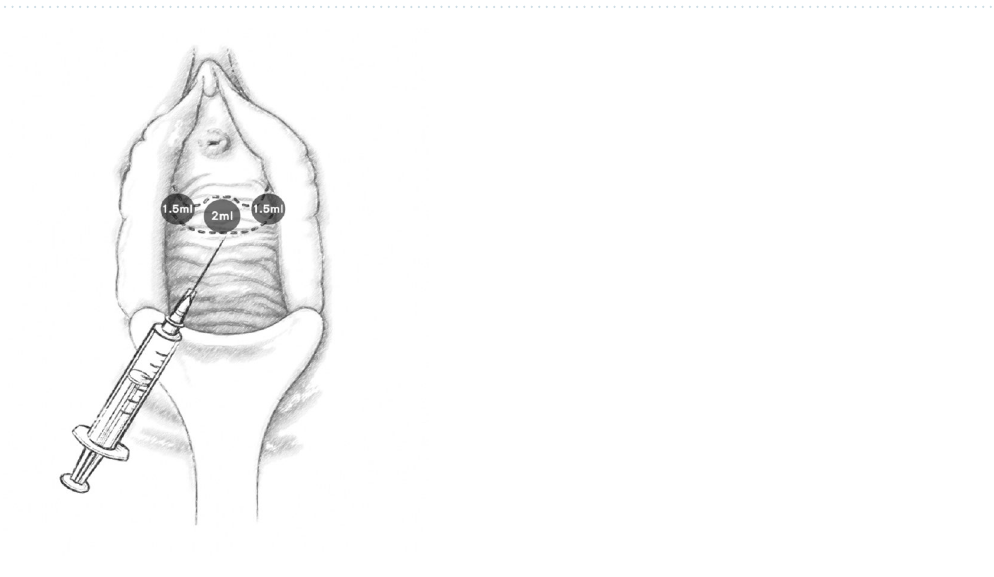
Figure 3. Diagram of the injection site and depth over anterior vaginal